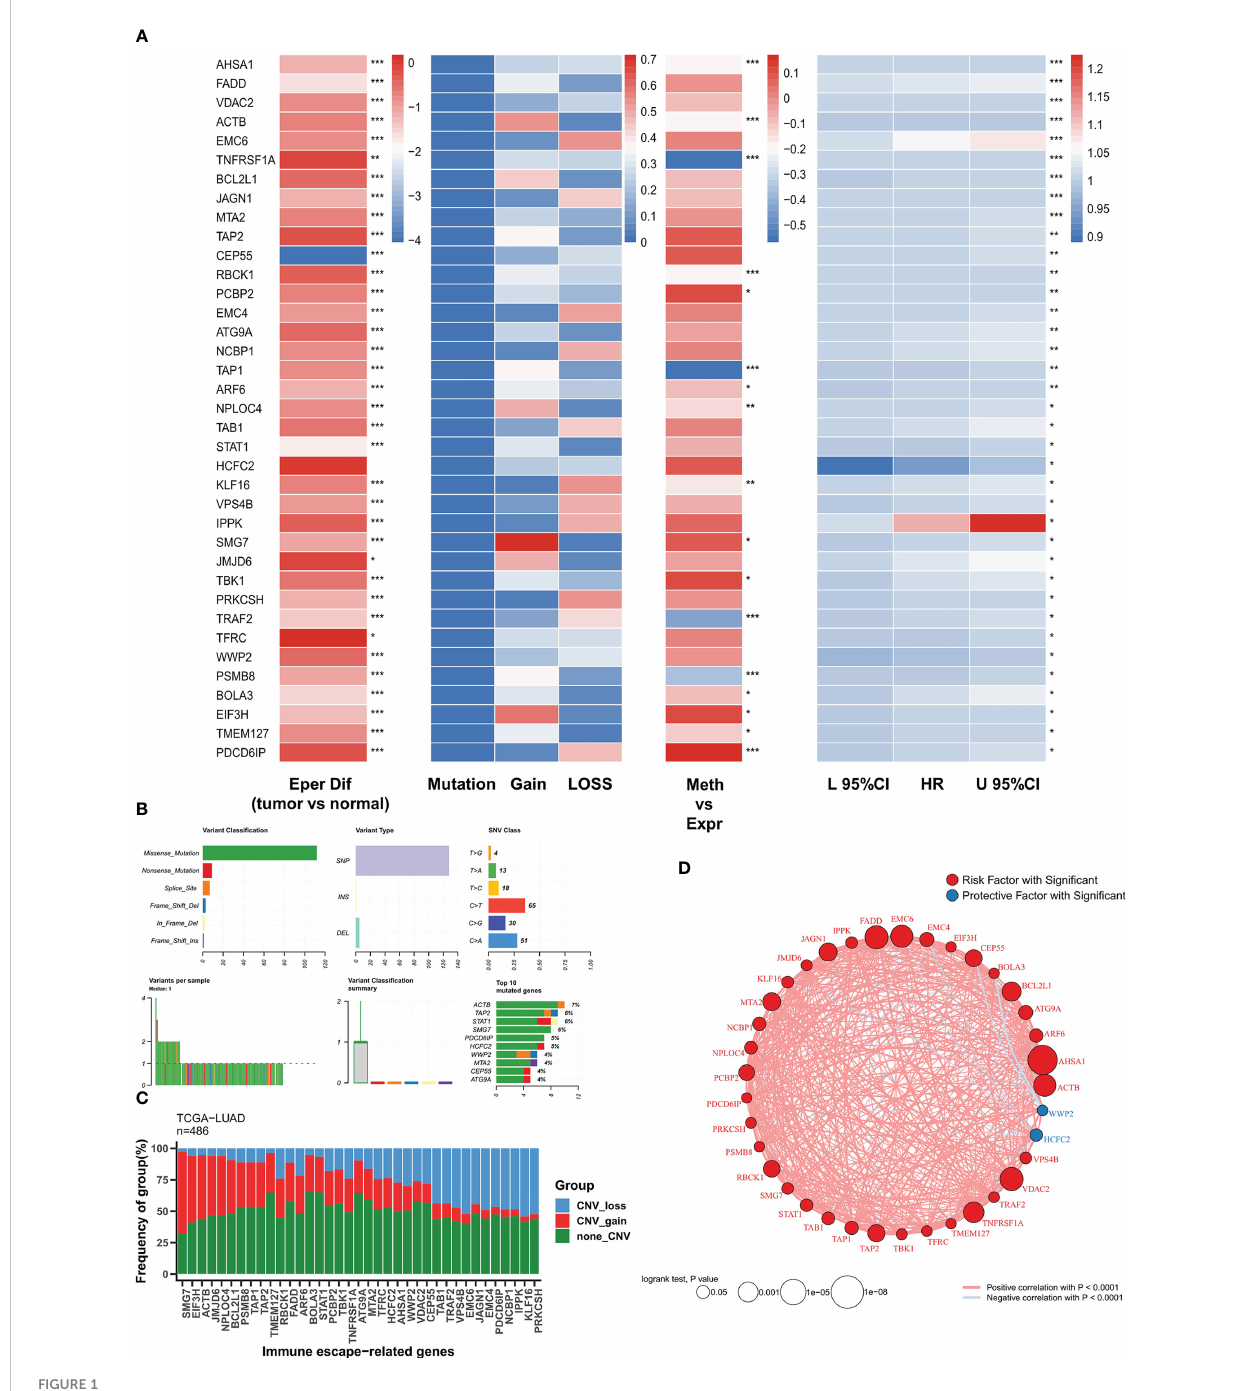
FIGURE 1 The genomic pro fi les of immune escape genes in TCGA-LUAD (A) Multi-omics transcriptome pro fi les of immune escape genes in TCGA-LUAD. From left to right: analysis of variance, genomic alterations, methylation correlation, univariate Cox regression. (B) Summary of single nucleotide mutations of immune escape genes in TCGA-LUAD. (C) Summary of copy number variations of immune escape genes in TCGA-LUAD. (D) Correlation network of immune escape genes. :*P<0.05, **P<0.01,